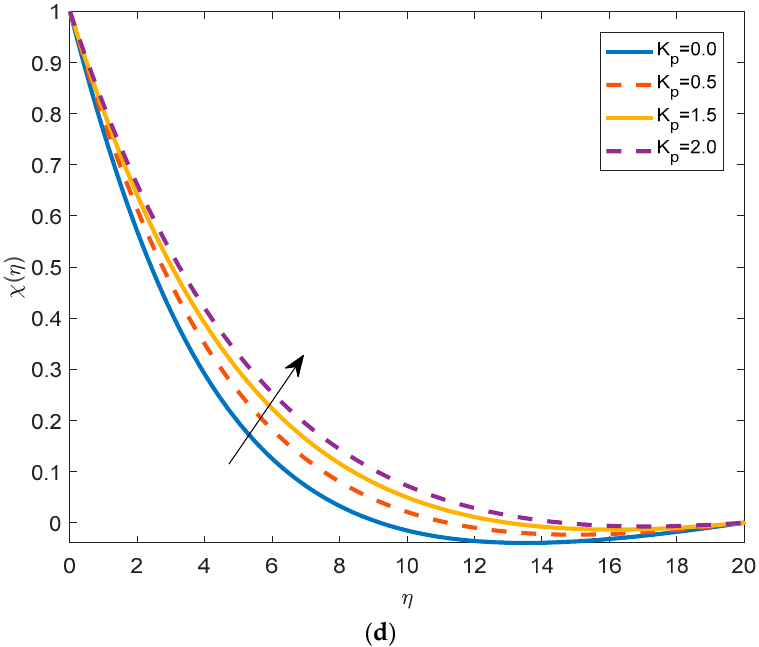
Figure 8. ( a ): Velocity distribution for porosity parameter 𝐾 (cid:3043) when 𝑁𝑡 = 0.1, Nb = 2.0, M = 1.0, Pr = 1.5, 𝑅𝑏 = 0.1, 𝜆 = 0.2, Sc = 0.5, 𝑆𝑐 (cid:3041) = 0.5, Pe = 1.0 ,𝑊 (cid:3032) = 0.2 at 𝛼 = 𝜋/6 . ( b ): Temperature distribution for various porosity parameter 𝐾 (cid:3043) when 𝑁𝑡 = 0.1, Nb = 2.0, M = 1.0, Pr = 1.5, 𝑅𝑏 = 0.1, 𝜆 = 0.2, Sc = 0.5, 𝑆𝑐 (cid:3041) = 0.5, Pe = 1.0 𝑊 (cid:3032) = 0.2 at 𝛼 = 𝜋/6 . ( c ): Concentration distribution for 𝐾 (cid:3043) when 𝑁𝑡 = 0.1, Nb = 2.0, M = 1.0, Pr = 1.5, 𝑅𝑏 = 0.1, 𝜆 = 0.2, Sc = 0.5, 𝑆𝑐 (cid:3041) = 0.5, Pe = 1.0 𝑊 (cid:3032) = 0.2 at 𝛼 = 𝜋/6 . ( d ): Density of motile micro-organisms for various 𝐾 (cid:3043) when 𝑁𝑡 = 0.1, Nb = 2.0, M = 1.0, Pr = 1.5, 𝑅𝑏 = 0.1, 𝜆 = 0.2, Sc = 0.5, 𝑆𝑐 (cid:3041) = 0.5, Pe = 1.0 𝑊 (cid:3032) = 0.2 at 𝛼 = 𝜋/6 .